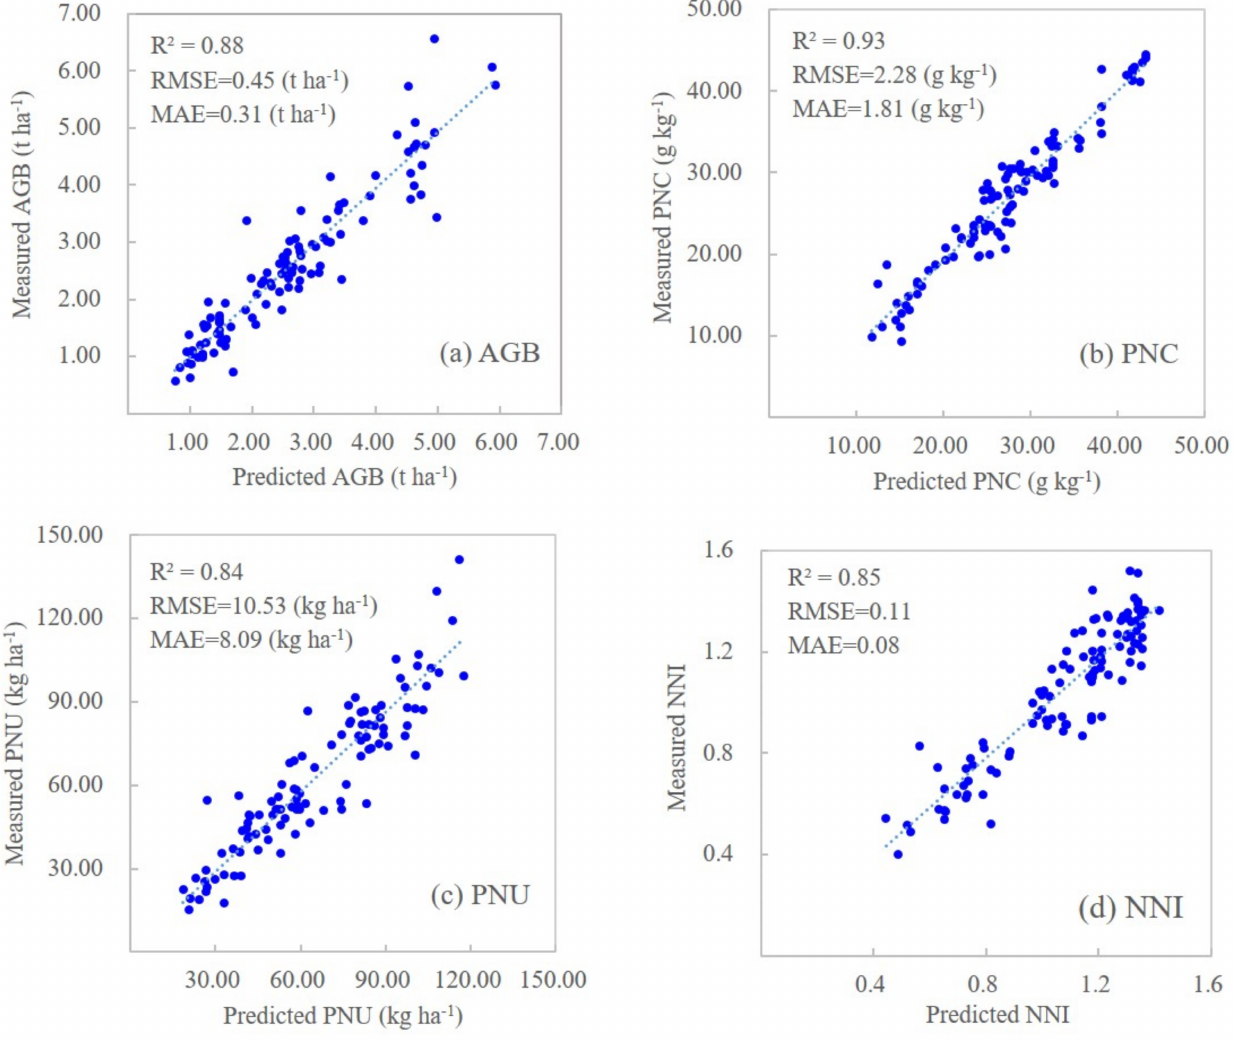
Figure 2. Scatterplots of measured and predicted corn N indicators for prediction dataset (n = 104) based on random forest regression models using NDVI and NDRE together with ge- netic, environmental (soil and climatic) and management variables for predicting aboveground biomass ( a ), plant N concentration ( b ), plant N uptake ( c ), and N nutrition index ( d